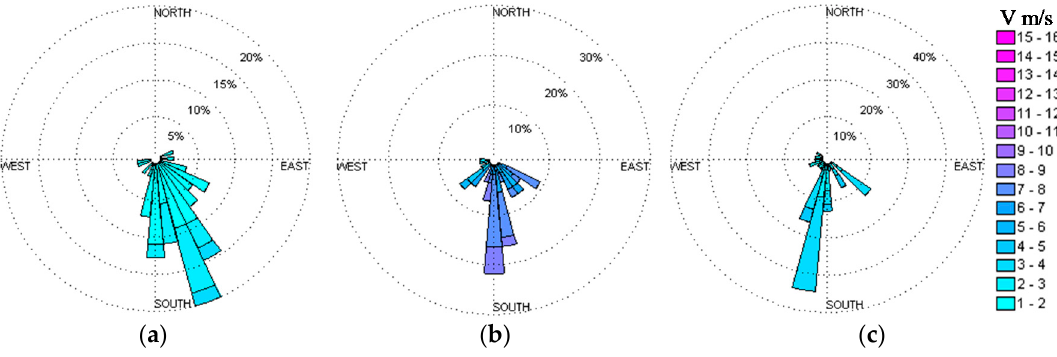
Figure 5. P3 wind roses for ( a ) NUIG measured wind, and HR modeled winds at ( b ) C1 and ( c )